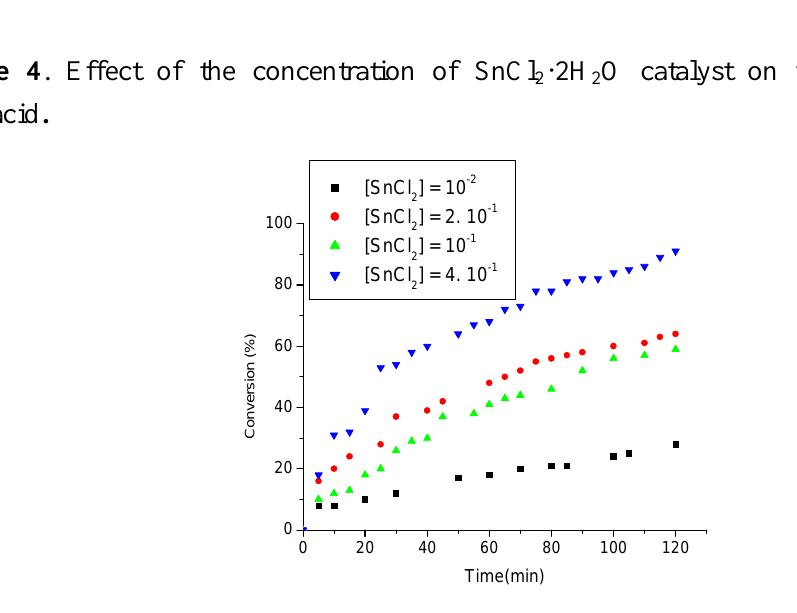
·2H O catalyst on the ethanolysis of 2 2